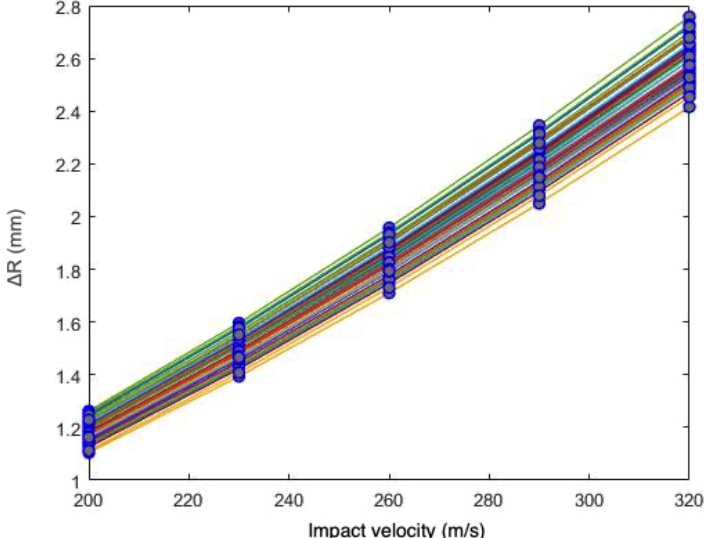
Figure 5. Linear interpolation of meta-model predictions of ∆ R for the Zerilli–Armstrong constitutive